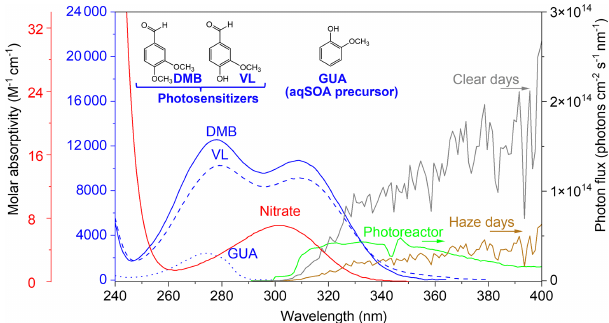
Figure 1. The base-10 molar absorptivities (M − 1 cm − 1 ) of 3,4- dimethoxybenzaldehyde (DMB, solid blue line), vanillin (VL, dashed blue line), guaiacol (GUA, dotted blue line), and nitrate (solid red line). The green line is the photon flux in the aqueous photoreactor. The gray and brown lines are the photon fluxes on typical clear and haze days, respectively, in Beijing, China (Mabato et al., 2022). The top of the figure also shows the structures of DMB, VL, and